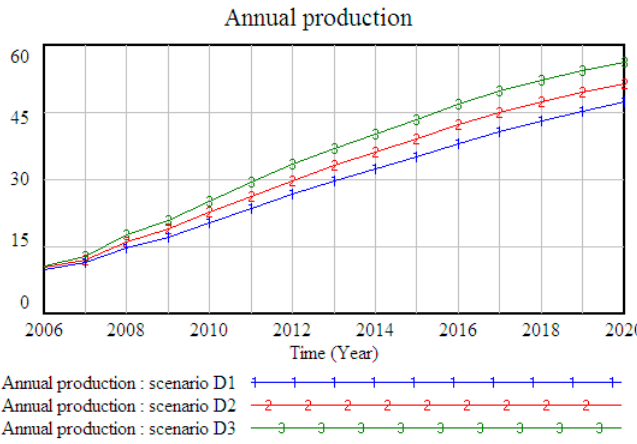
Figure 12. Annual production (billion cubic meters).